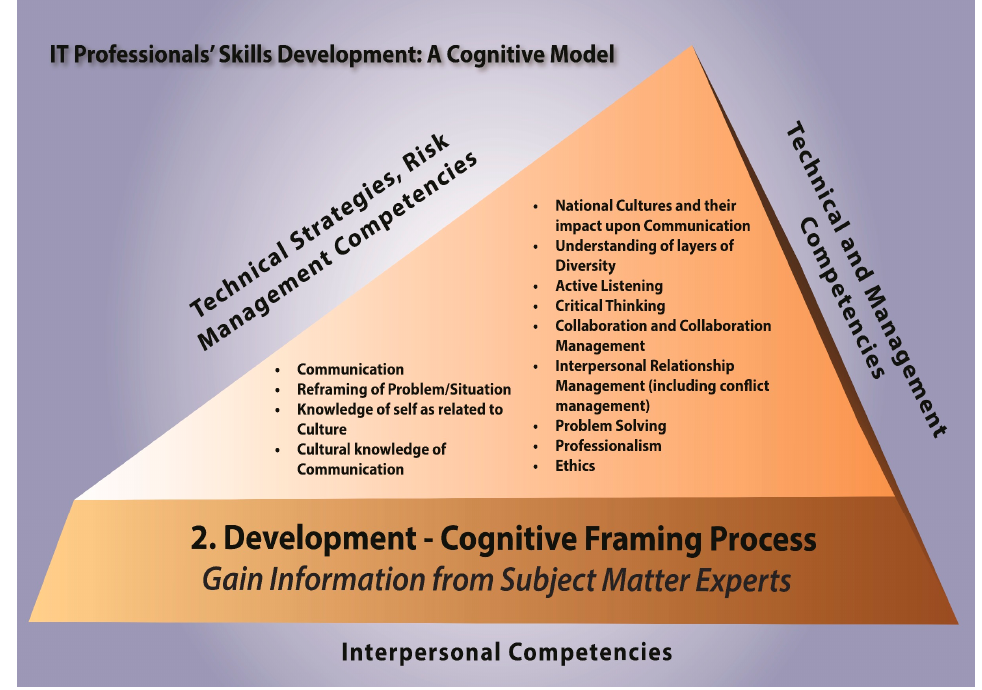
Figure 3. Illustration of the Necessary Non-technical Skills for Step 2: Development-Cognitive Framing Process Social Intuition and Contextual Awareness within a simulated IT Project Systems Development Life Cycle Context.